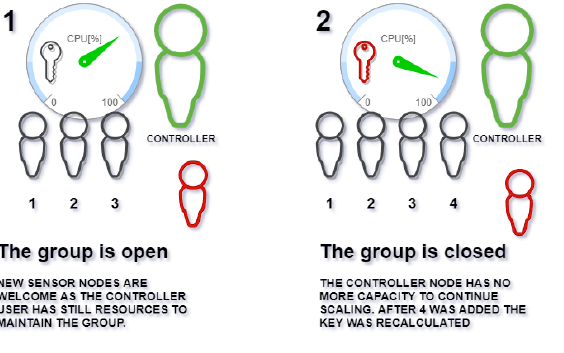
Figure 8. Scaling of the